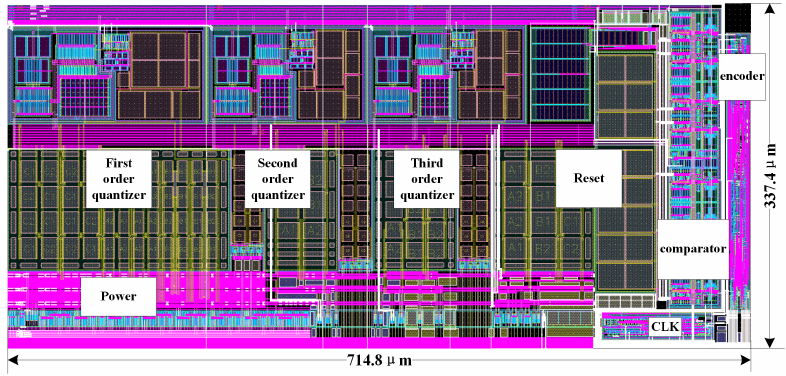
Figure 10. Layout of the Sigma-Delta modulator.